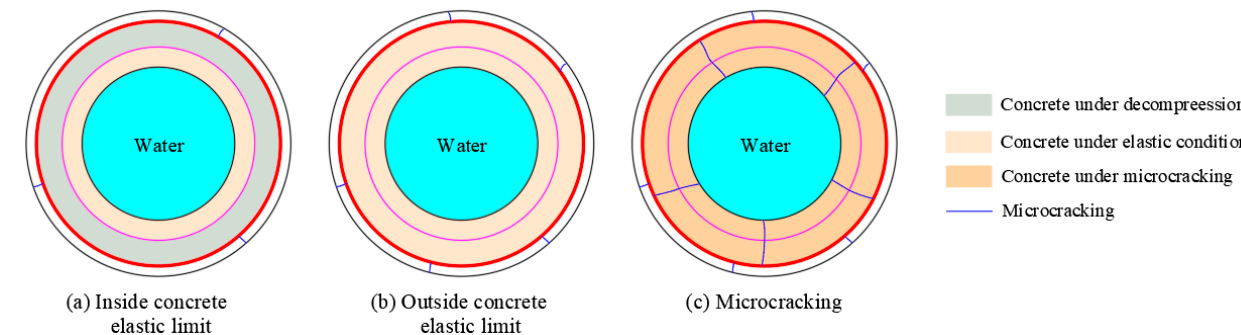
Figure 17. Concrete microcracking stage.